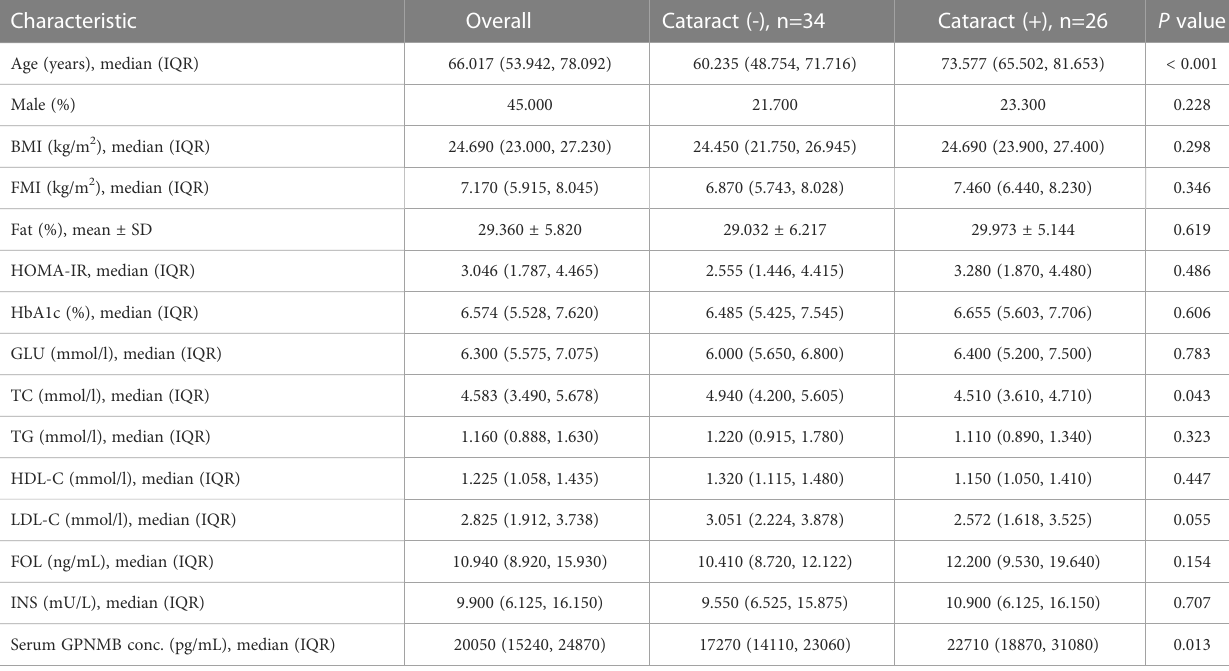
TABLE 3 Clinical and biochemical characteristics of study participants with diabetes classi fi ed according to cataract. Characteristic